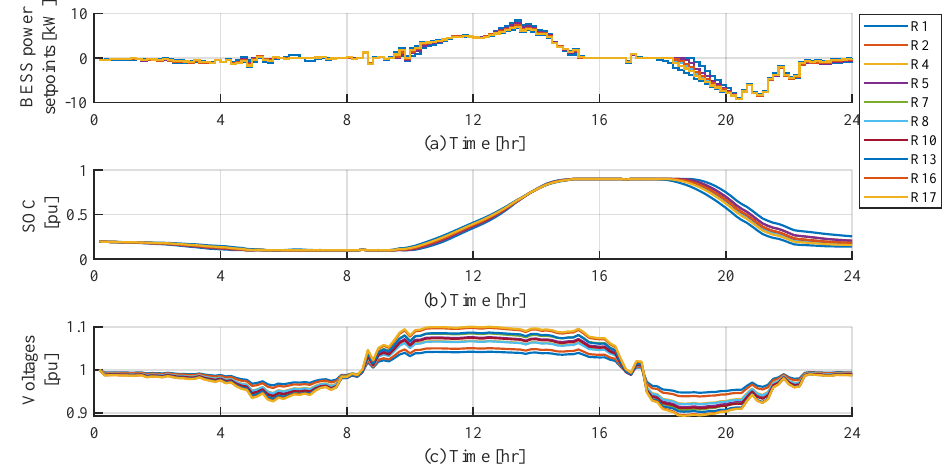
Figure 6. Plot of case 2: ( a ) setpoints of BESS, ( b ) State of Charge of the Battery energy storage systems (BESS) of BESS, and ( c ) node voltages at end of the